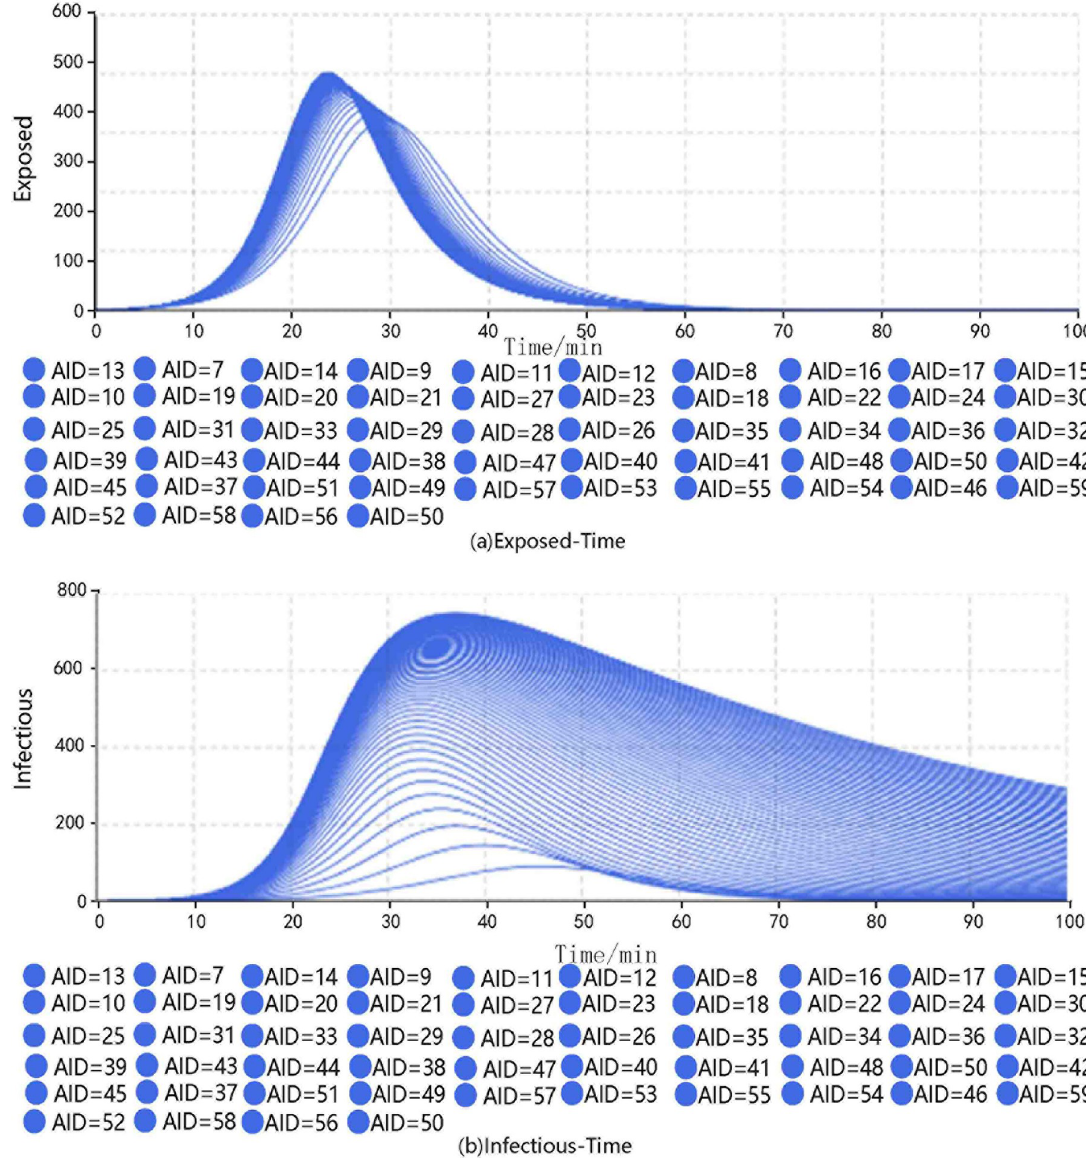
Fig 7. Exposure-infection curve under different durations of infection.